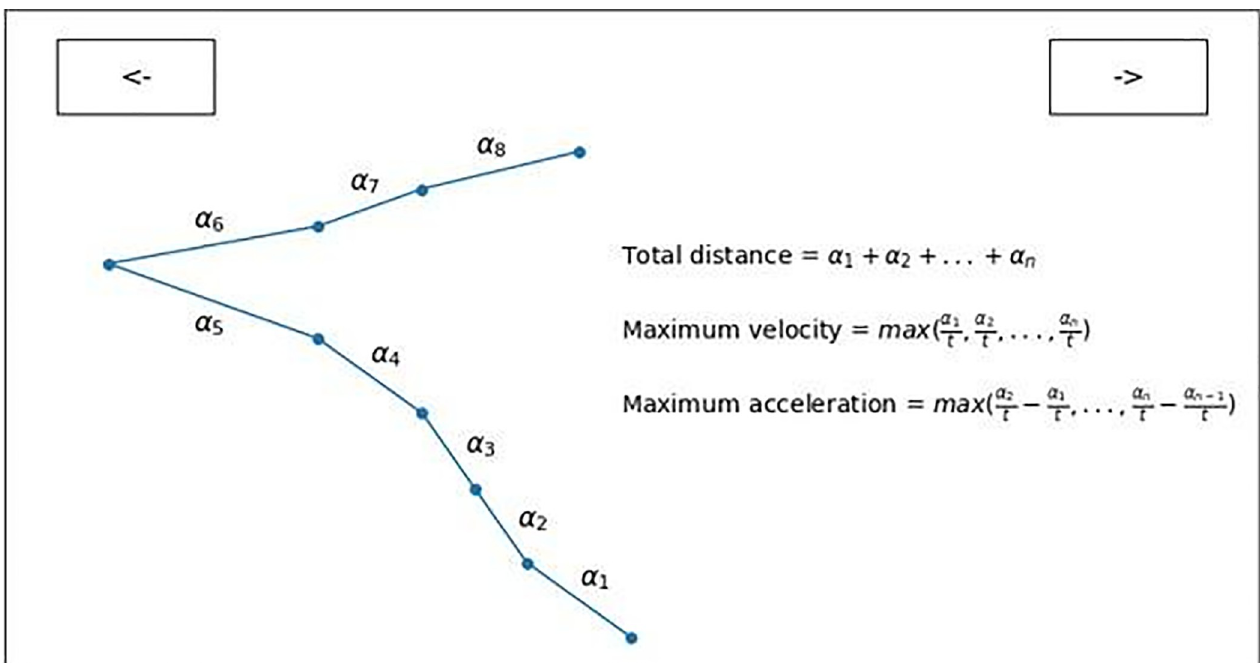
Fig 2. Calculation of trajectory-based measures. Note: t represents the time between recordings ( � 19 ms). Maximum velocity was calculated as the maximum speed with which the movement between two adjacent sets of coordinates took place. Maximum acceleration stands for maximum change in the velocity of the mouse movement between the two adjacent parts of the trajectory. Mean total distance represents the mean of total Euclidean distance from the original starting position of the cursor to the position of the cursor at the end of the trial.